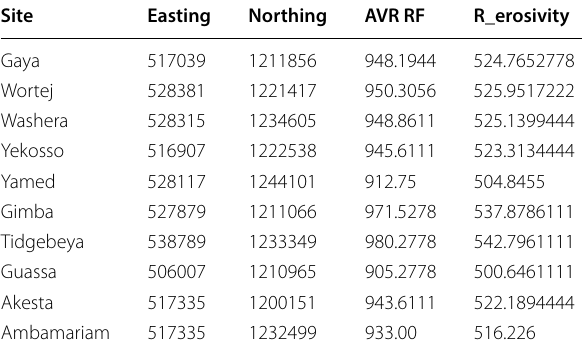
Table 12 Rain fall erosivity of sample sites used for